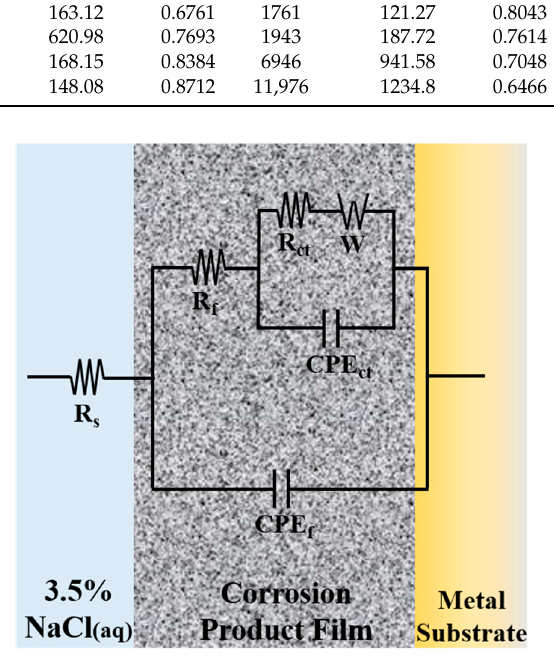
Figure 6. Equivalent circuit model used to fit the Nyquist plots data in Figure 5d.